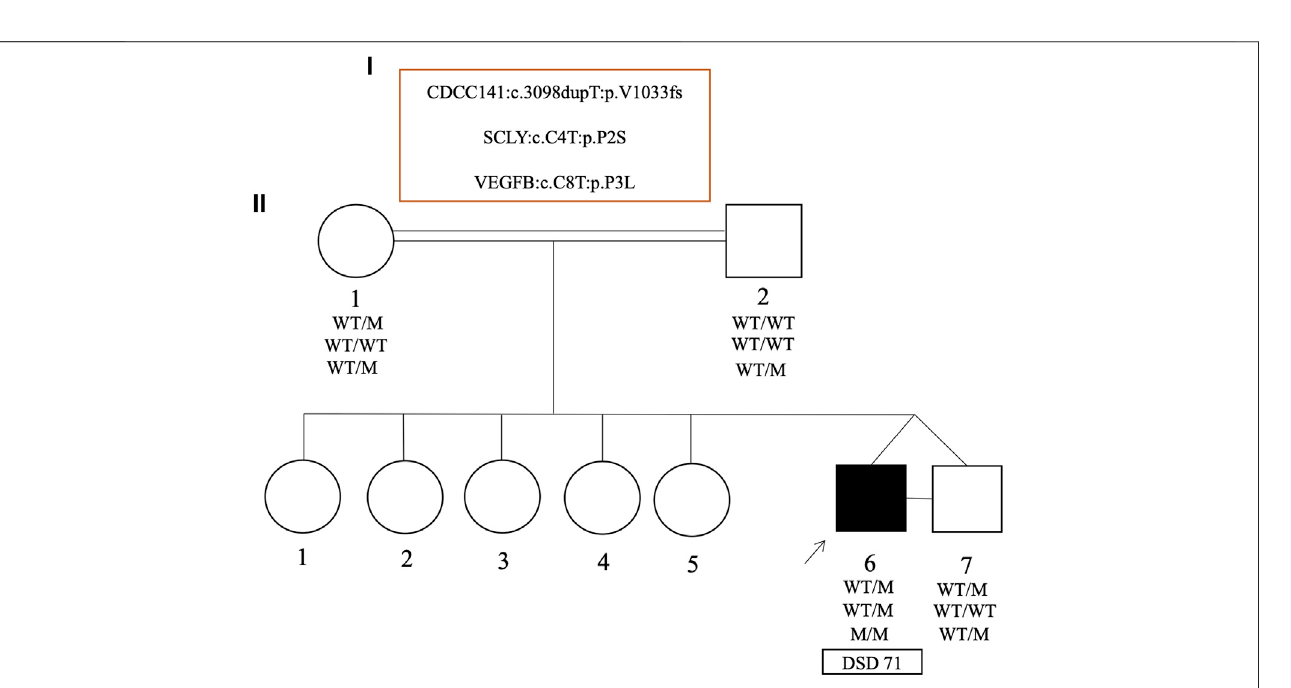
FIGURE5| Pedigreesandrepresentativesegregationofthecuratedvariantsinthemonozygotictwins(case71)discordantfor46,XYDSD.Thegenotypeoffamily members is indicated. Squares represent male family members and circles represent female family members. Solid squares represent the affected 46, XY subject who was raised as a boy.